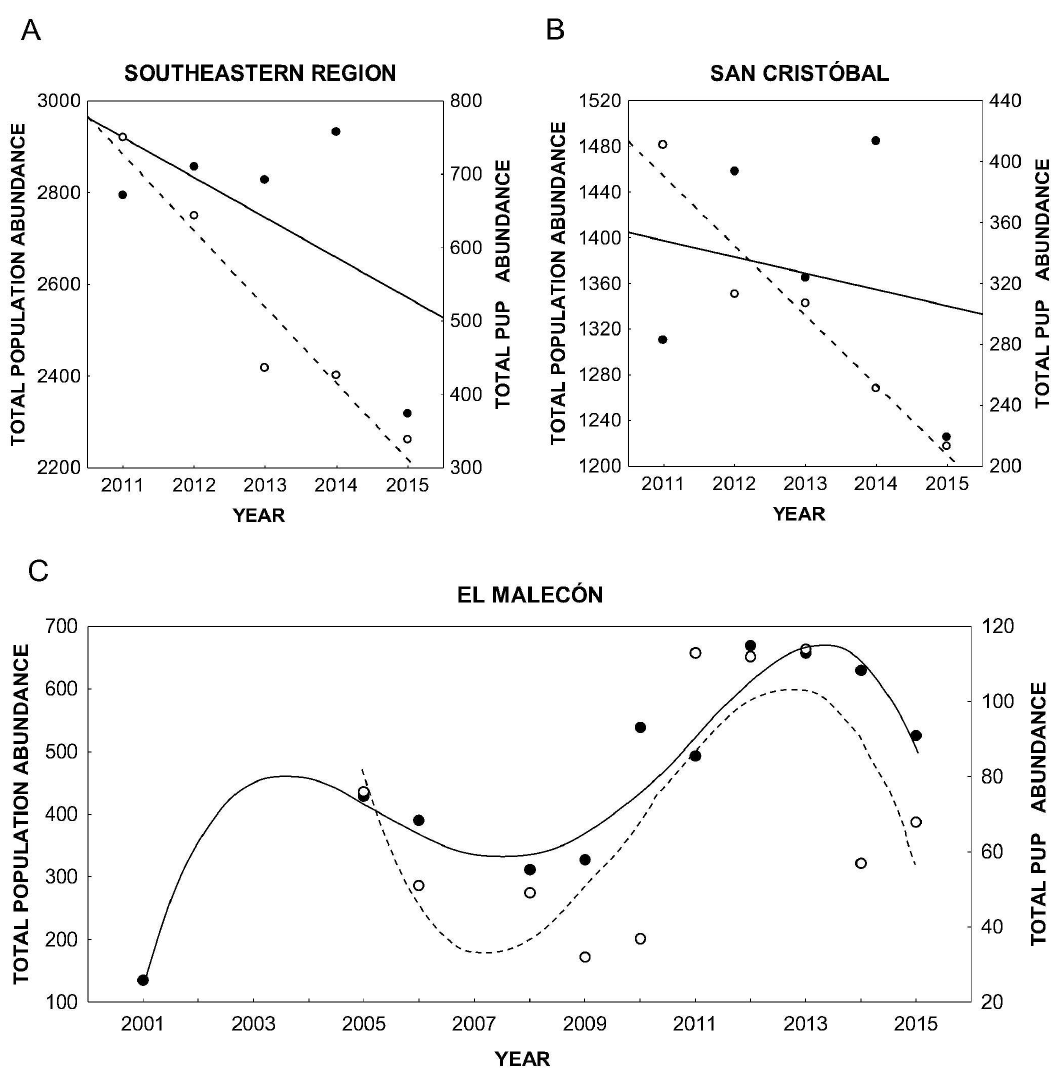
Fig 3. Population and pup abundance trends of Galapagos sea lions. A) Southeastern region(SER) from 2011 to 2015 (including 13 rookeriesdistributed on four islands); B) San Cristo´bal Island (SC) from 2011 to 2015 (including five rookeries); C) El Maleco´n rookery from 2005 to 2015. Filled and opencircles show the total populationand pup population in each case, respectively.Solid and dashedlines show the population trends and the pup abundance trends, respectively. The time periods analyzedin each case correspond to those with completedata series for all rookeries, with the exceptionof 2011–2013in the regionaldataset, for which the total numberof pups was estimated based on the total pups counted and the percentageof the populationsurveyedin each year. The pup abundance trends on SC and in the SER show a significantadjustmentto a linear model.